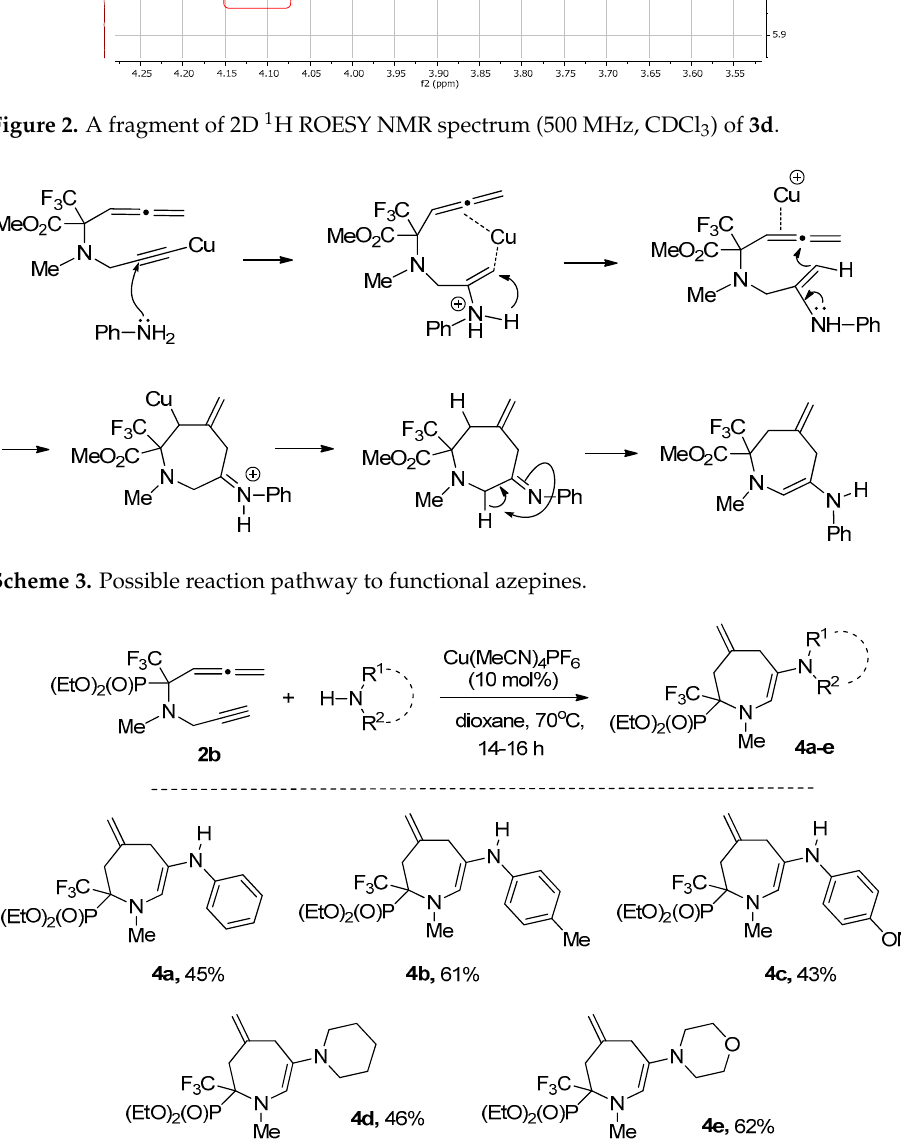
Figure 2. A fragment of 2D 1 H ROESY NMR spectrum (500 MHz, CDCl 3 ) of 3d